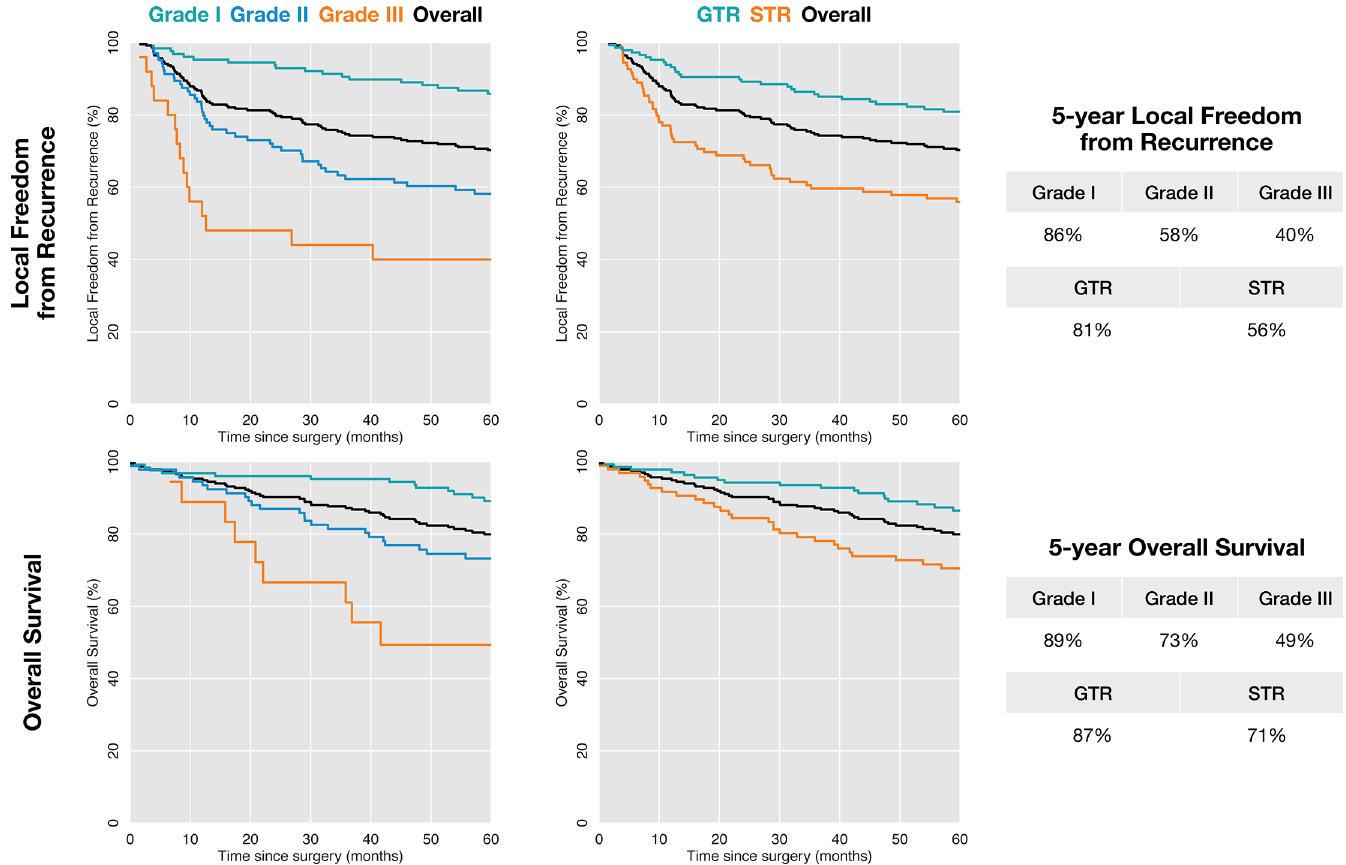
Fig 1. Meningioma outcomes according to conventional predictive factors. Kaplan-Meier estimates for local freedom from recurrence (top) and overall survival (bottom) following surgery for meningioma according to conventional predictive factors of meningioma grade (left) and extent of resection (right).